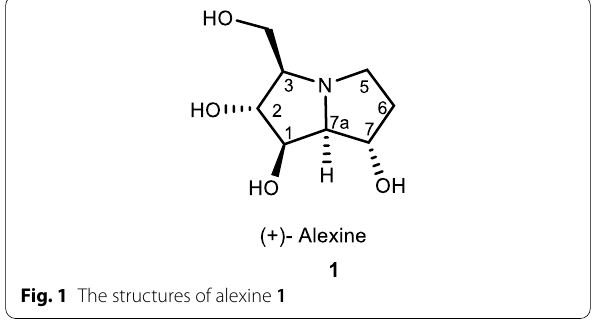
Fig. 1 The structures of alexine 1